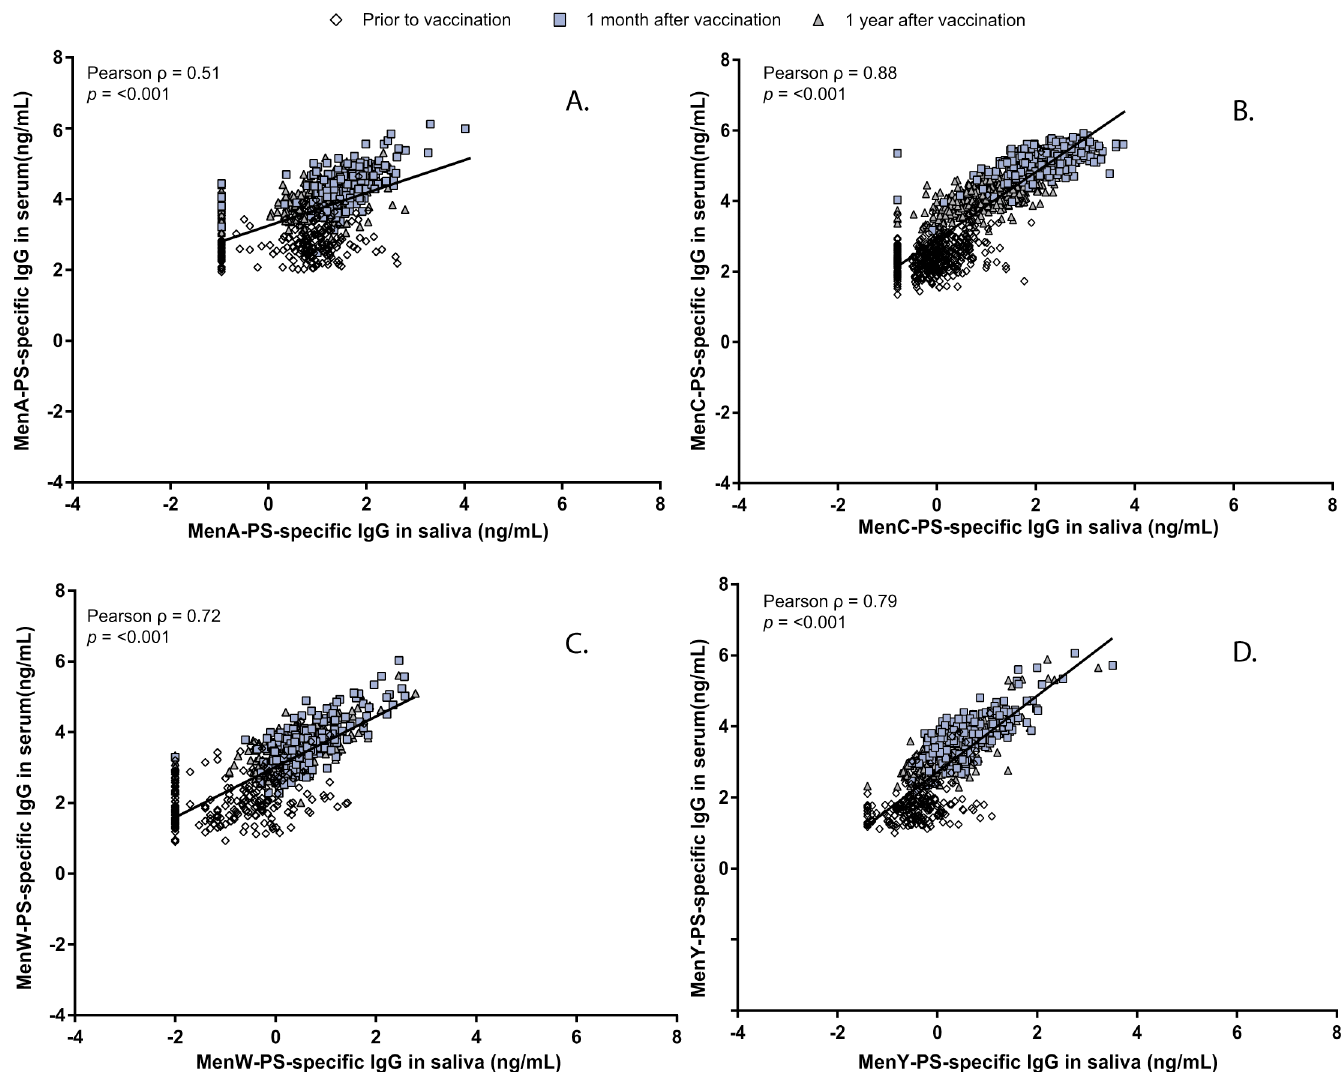
Fig 2. Correlation between log-transformed Immunoglobulin G (IgG) levels in saliva and serum for meningococcal serogroup A (A), C (B), W (C), and Y (D).